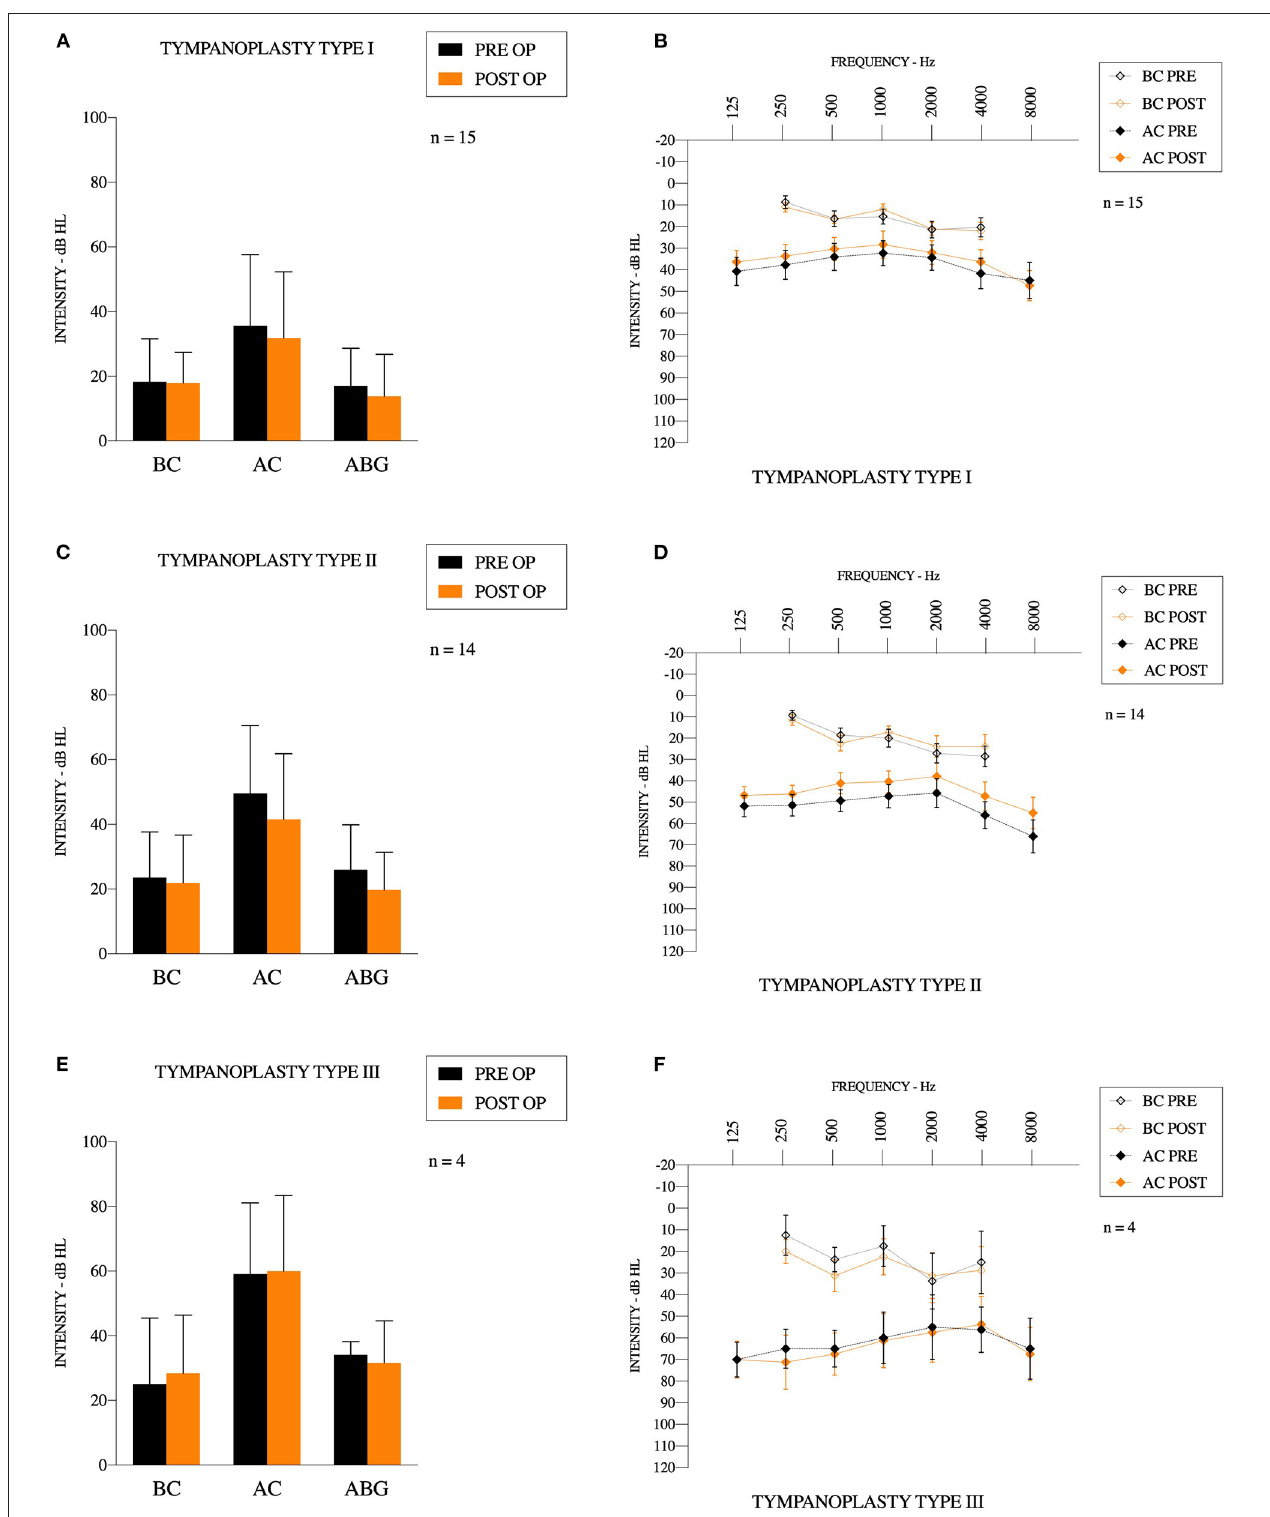
FIGURE 4 | Audiometric results (A,C,E) results for bone conduction, air conduction and air-bone gap for Type 1,2, and 3 tympanoplasties, respectively. (B,D,F) Mean preoperative and postoperative audiogram for Type 1,2, and 3 tympanoplasties, respectively.